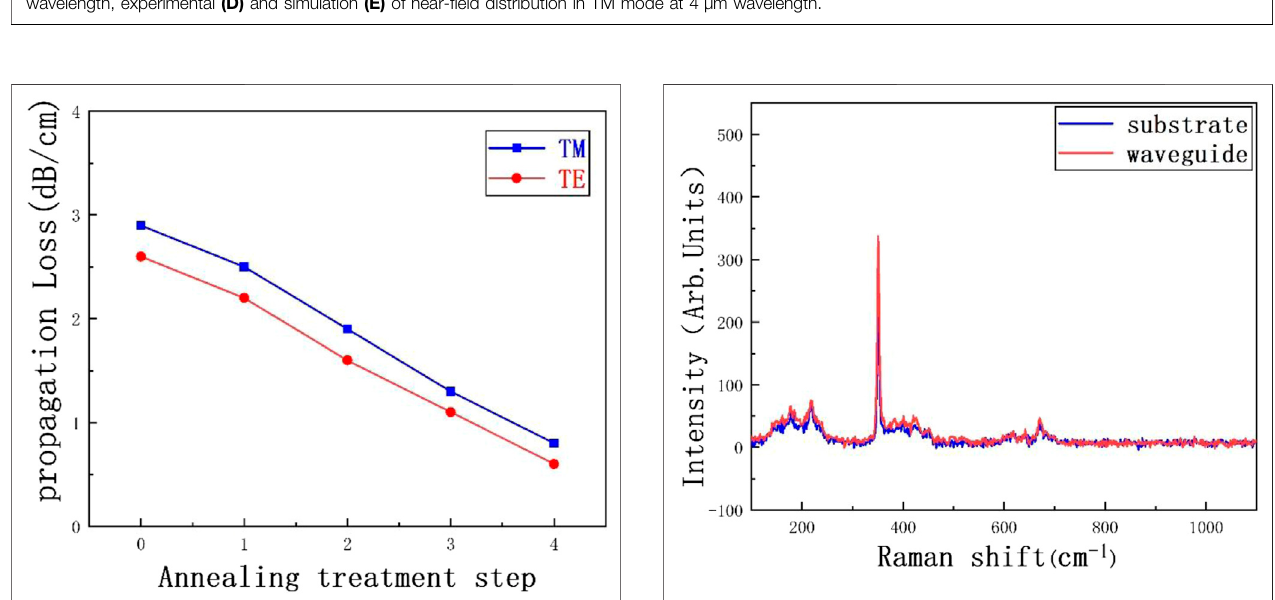
FIGURE 4 | Microscopic images of ridge waveguides of ZnS crystals (A) , experimental (B) and simulation (C) of near- fi eld mode distribution of TE mode at 4 μ m wavelength, experimental (D) and simulation (E) of near- fi eld distribution in TM mode at 4 μ m wavelength.